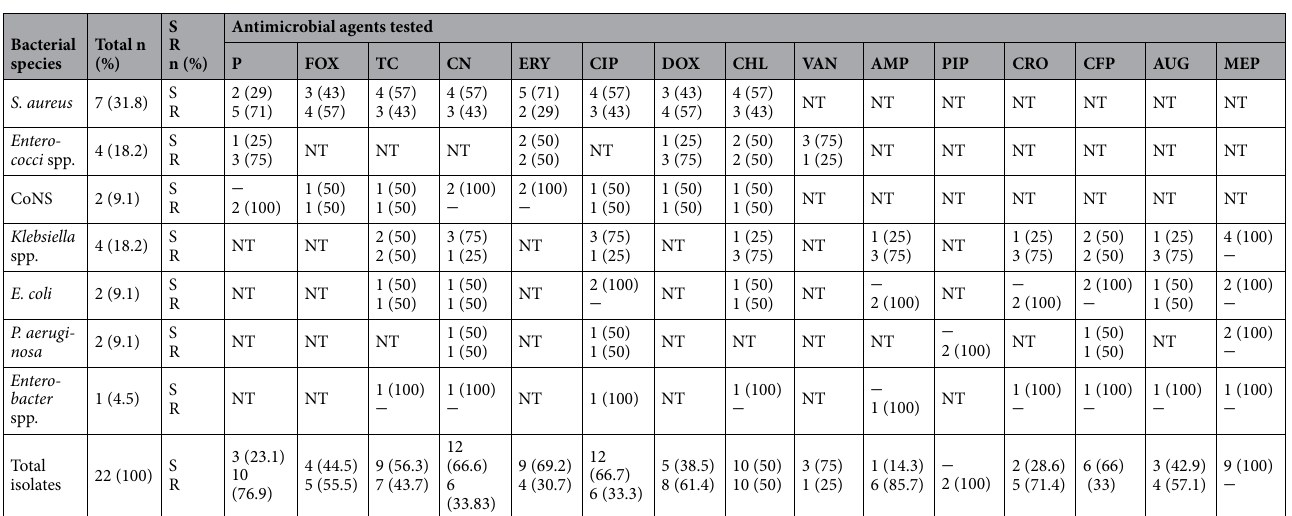
Table 3. Antimicrobial susceptibility patterns of bacterial isolates from blood cultures of patients attending at AMGH, southern Ethiopia. S: susceptible, R: resistant, NT: not tested. P: penicillin, FOX: cefoxitin, CHL: chloramphenicol, ERY: erythromycin, CN: gentamicin, TC: tetracycline, CIP: ciprofloxacin, VAN: vancomycin, DOX: doxycycline, AMP: ampicillin, PIP: piperacillin, CRO: ceftriaxone, AUG: amoxicillin-clavulanate, MEM: meropenem, CFP: cefapime. *NT corresponds to a change in denominator (total number of isolates